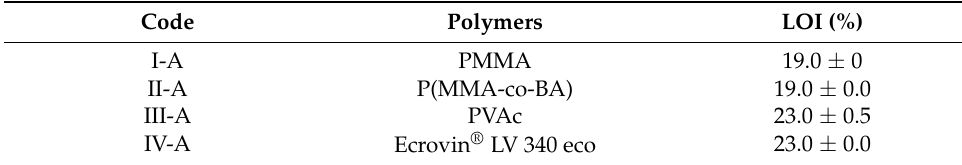
Table 1. LOI measurements of neat